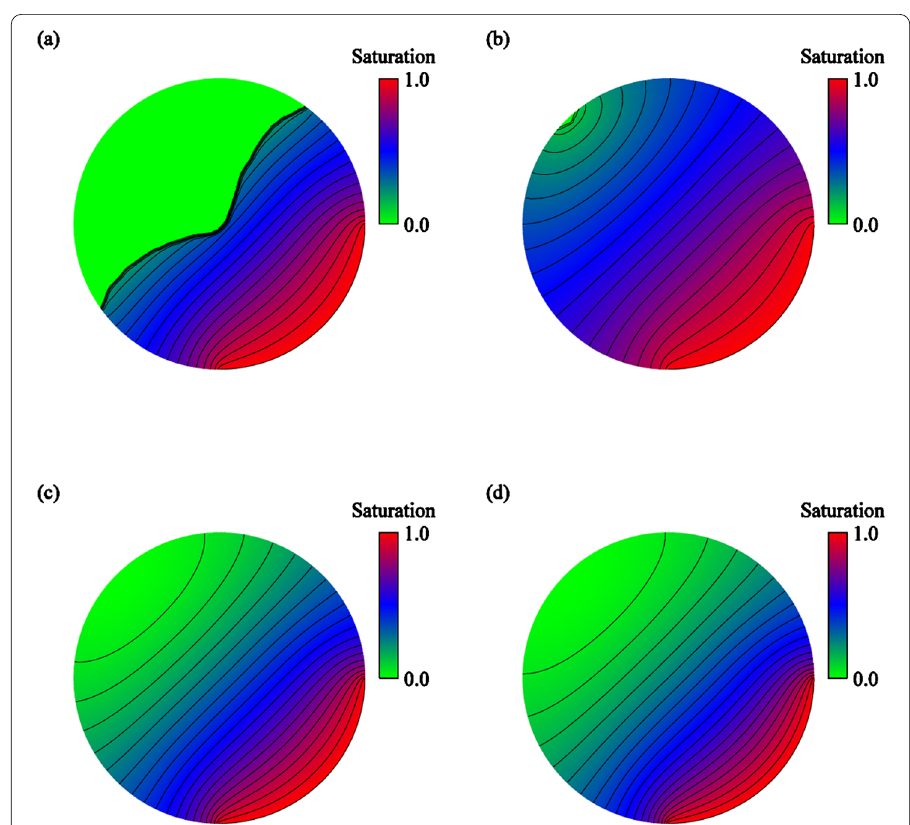
Figure 10 Computed saturation at each time for the horizontal displacement. The computational results at (a) 0.6 × 10 3 (s), (b) 1.2 × 10 3 (s), (c) 4.8 × 10 3 (s), and (d) 4.8 × 10 4 (s) (almost steady state), respectively. The contour lines for u = 0.05 n where n represent non-negative integers are